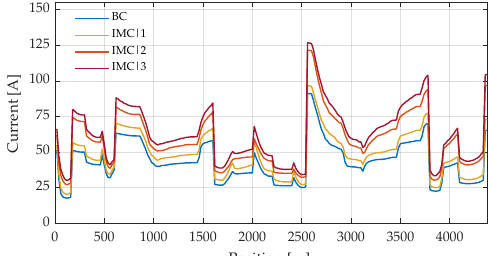
Figure 25. Maximum and minimum currents along the catenary ( left ), the 95% inter-percentile range ( right ), and maximum RMS currents in each position during the day (bottom) for the four considered scenarios.